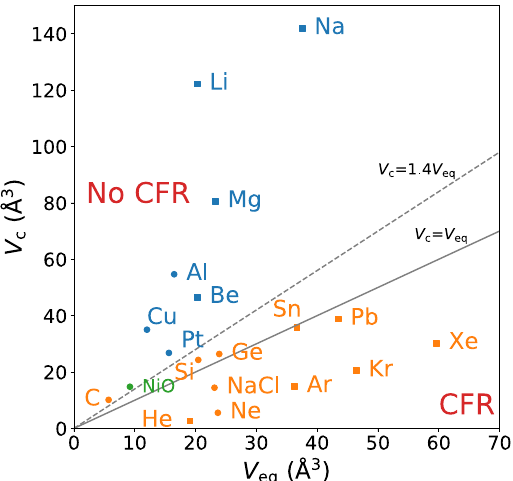
Fig. 1 CFRs at equilibrium for a variety of metals and insulators. Contrasting the amount of strain needed to induce a CFR for various solids at smaller equilibrium volume per atom V eq , for PBE only. For the complete fi gure, see Supplementary Fig. 4. Solids lying above the gray line V c = V eq have no CFR at equilibrium, and those below the line have a CFR at equilibrium. The line V c = 1.4 V eq better separates metals and insulators; the only exceptions are diamond and NiO. For clarity of the fi gure, only the rocksalt antiferromagnetic (AFM) phase of NiO (green) is shown; other phases are discussed